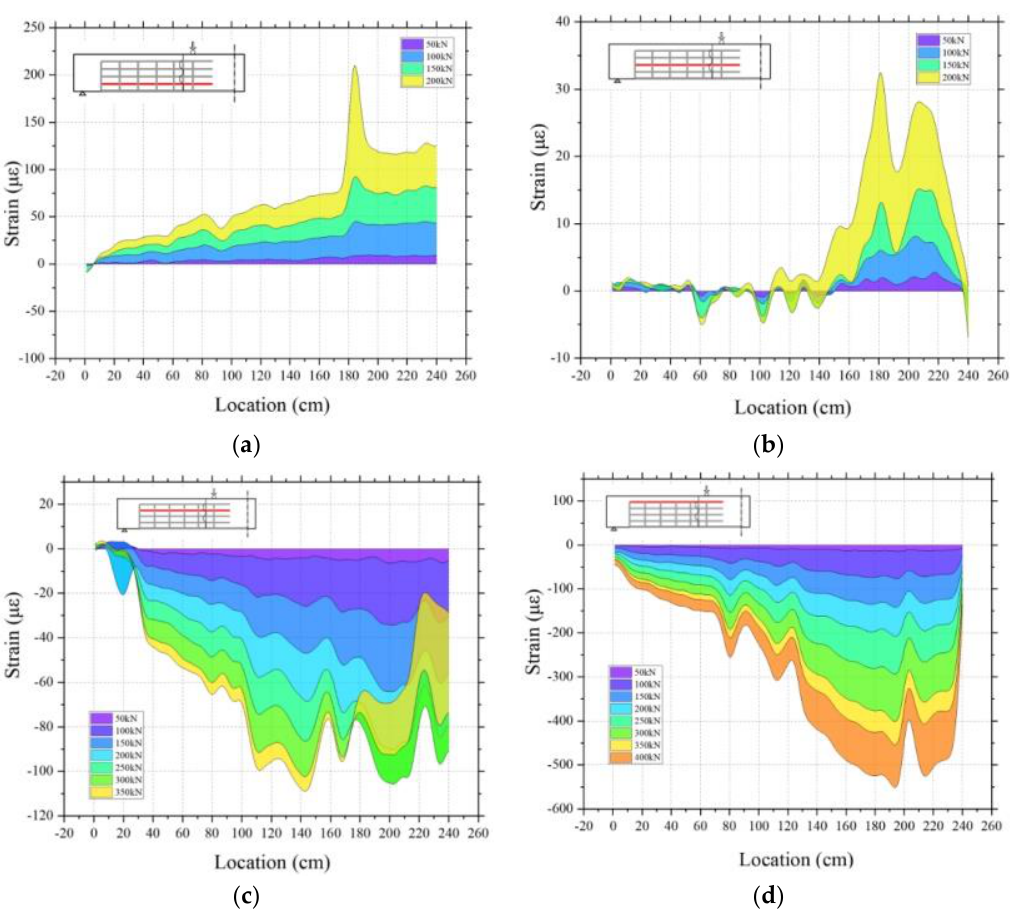
Figure 11. Longitudinal strain profiles at different cross-section depths for the segmental beam. a) 16 cm from the bottom, b) 32 cm, c) 48 cm, d) 64 cm